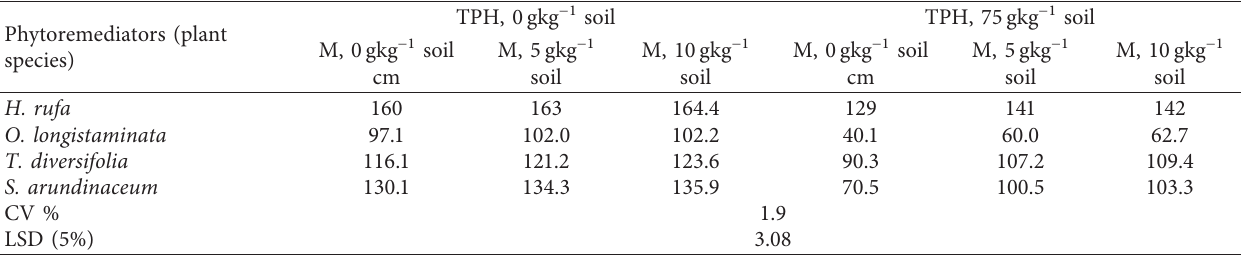
Table 3: Treatments effect on the height of four phytoremediators.